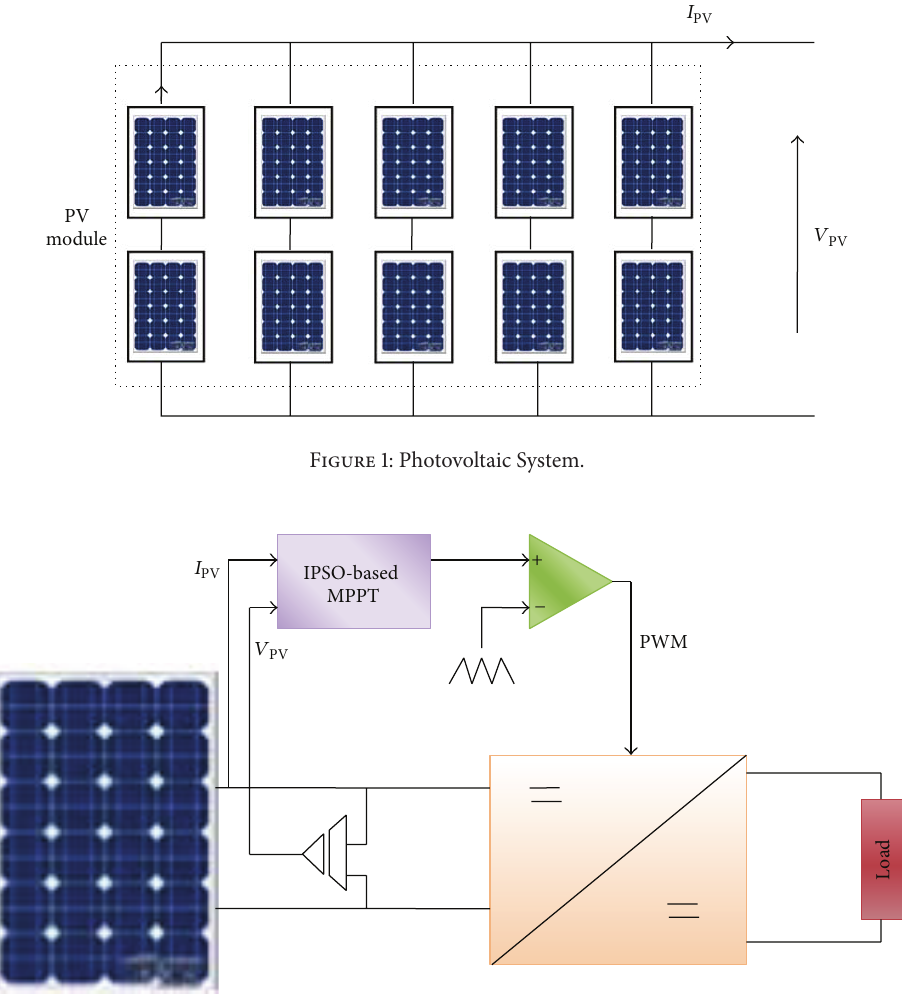
Figure 2: Configuration of the proposed PV